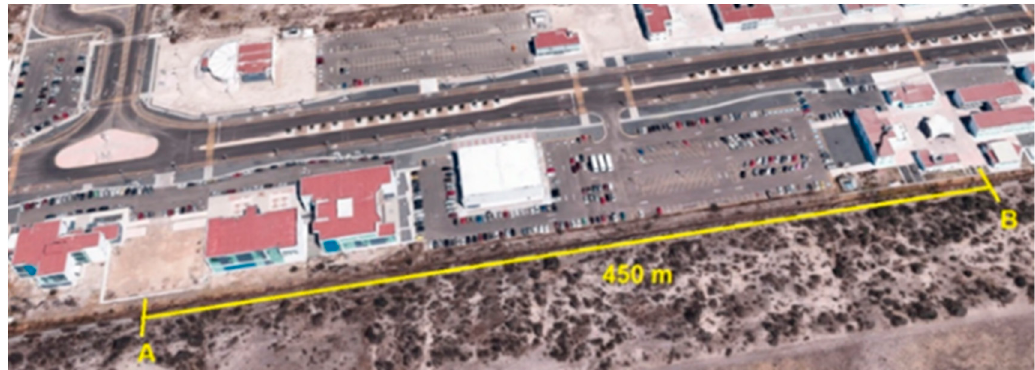
Figure 8. Installation area of the wind turbine and anemometer. Letter A indicates the installation site of the wind turbine, and letter B is the installation site for the anemometer.